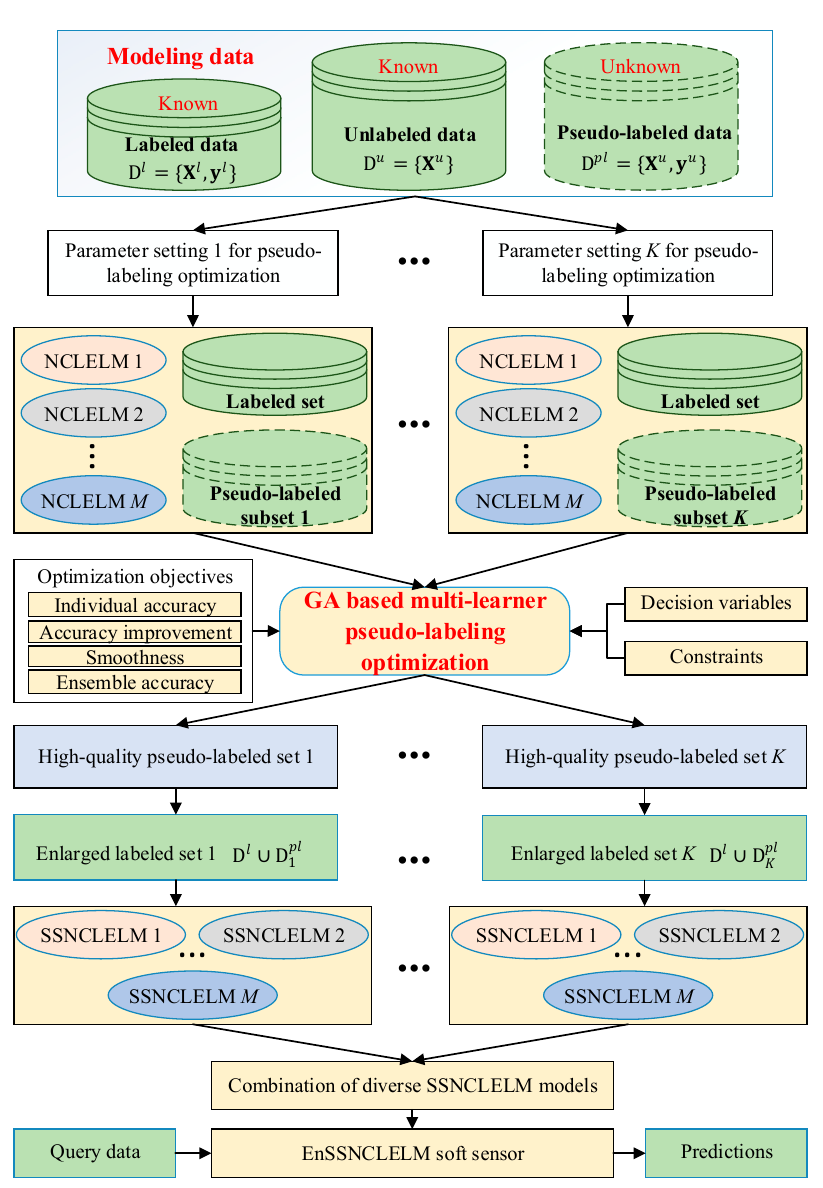
Figure 3. Workflow of the proposed EnSSNCLELM soft